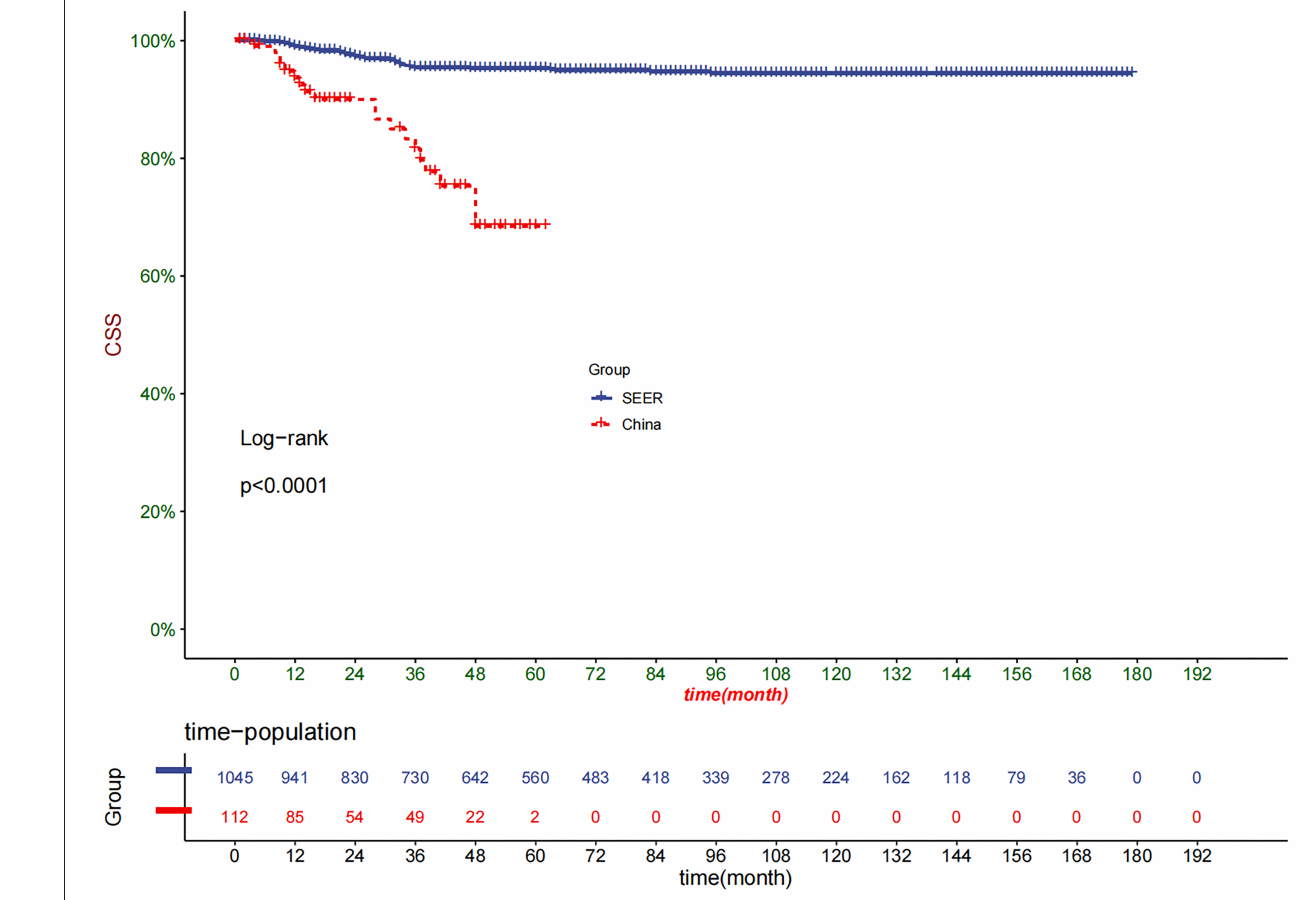
FIGURE 10 | Kaplan–Meier curves of CSS for children in SEER cohort and CHCMU